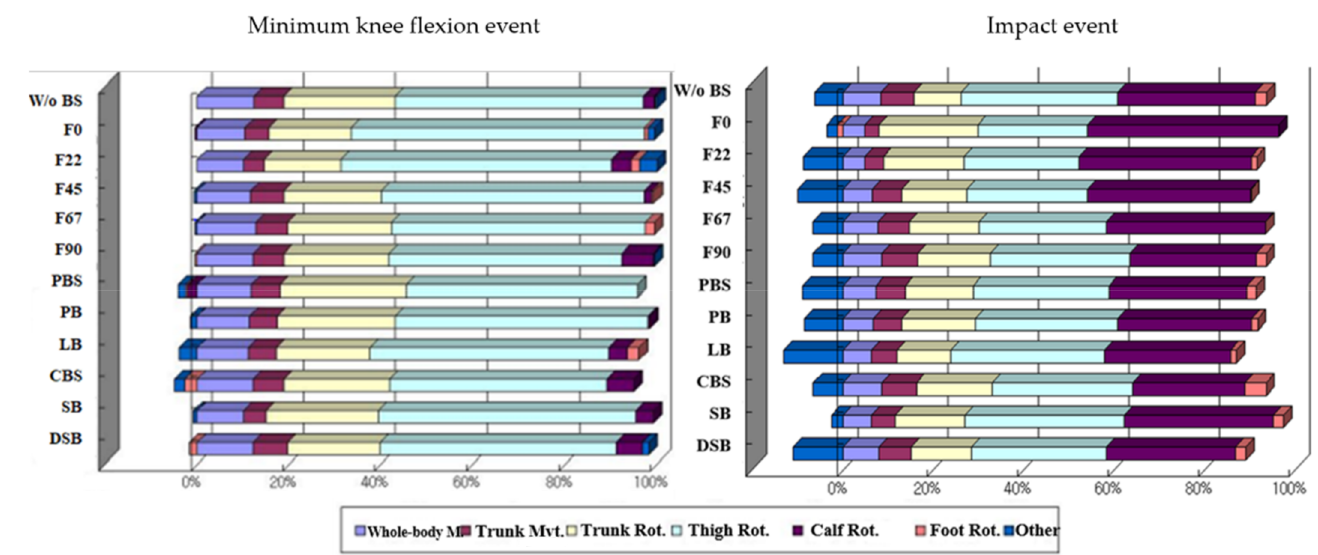
Figure 6. Comparison of the contribution rates in MKF and impact